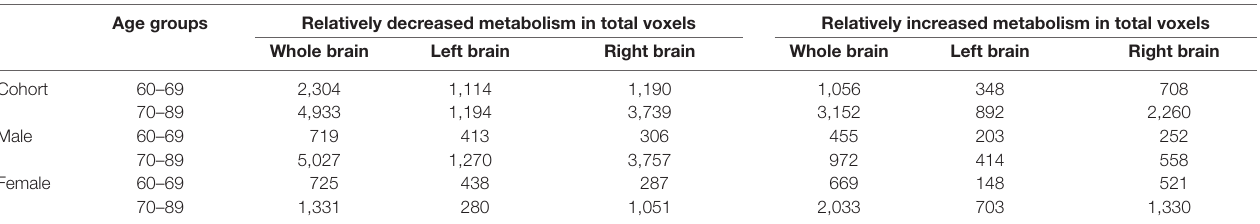
TABLE 8 | Changing of whole brain voxels in cohort and different gender